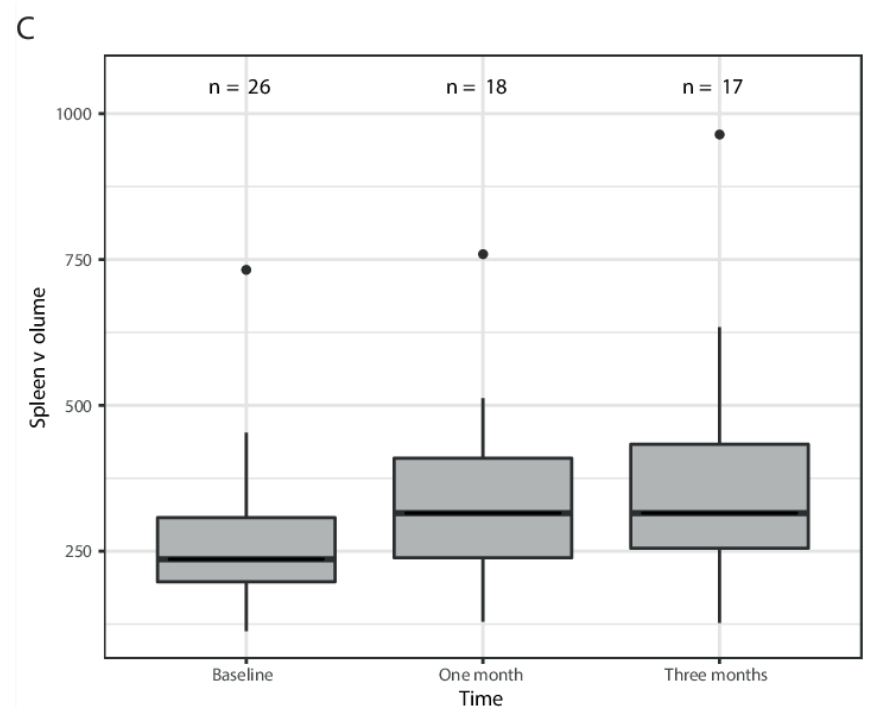
Figure 4. Changes in SUL blood ( A ) and SUL spleen ( B ) over time compared to baseline and changes in splenic volume ( C ) over time compared to baseline.